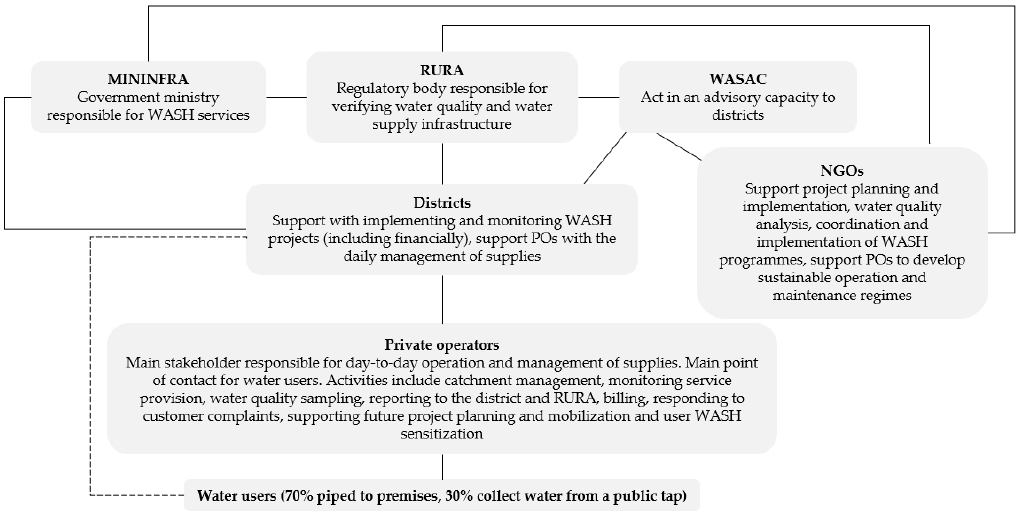
Figure 4. Communication channels and formal stakeholder collaboration methods relevant to provision of drinking water in Rwanda, as identified by respondents. The dashed line indicates an informal collaboration, solid lines indicate formal collaborations. RURA — Rwanda Utilities Regulatory Authority, MININFRA — Ministry of Infrastructure, WASAC — Water and Sanitation Corporation.